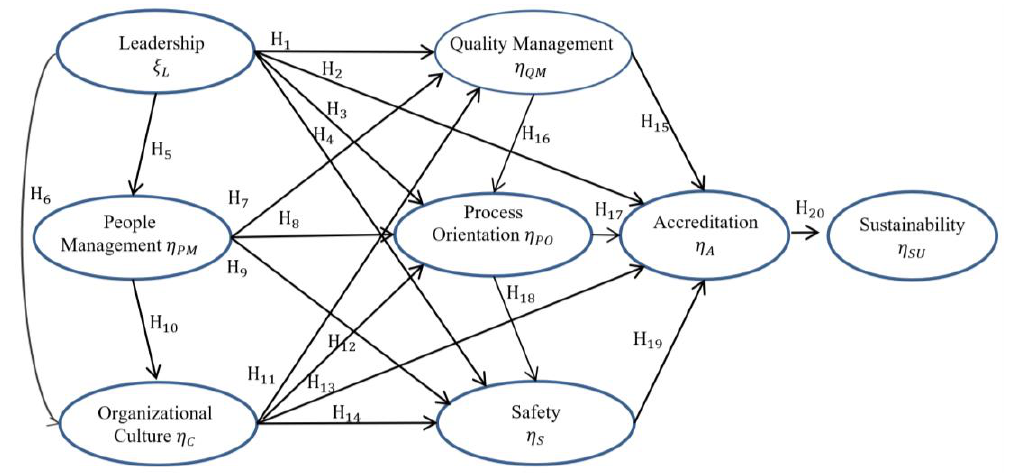
Figure 1. Basic conception of the model.